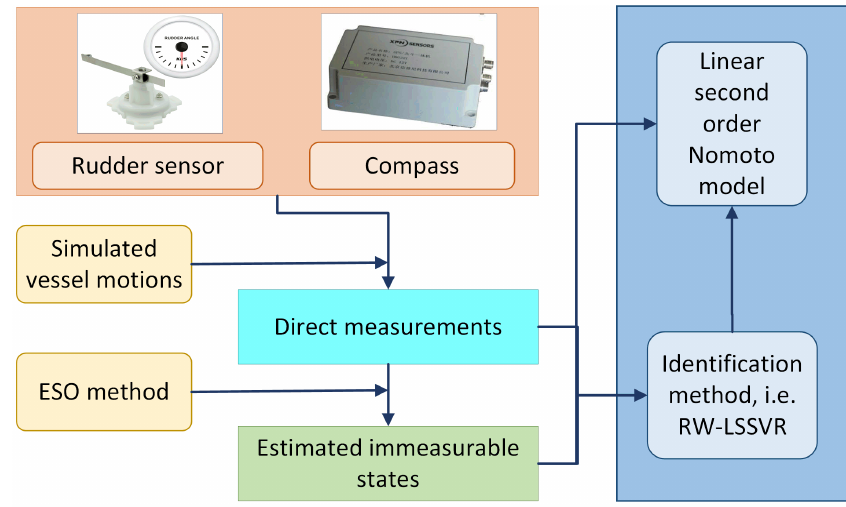
Figure 1. Framework of the proposed hybrid identification